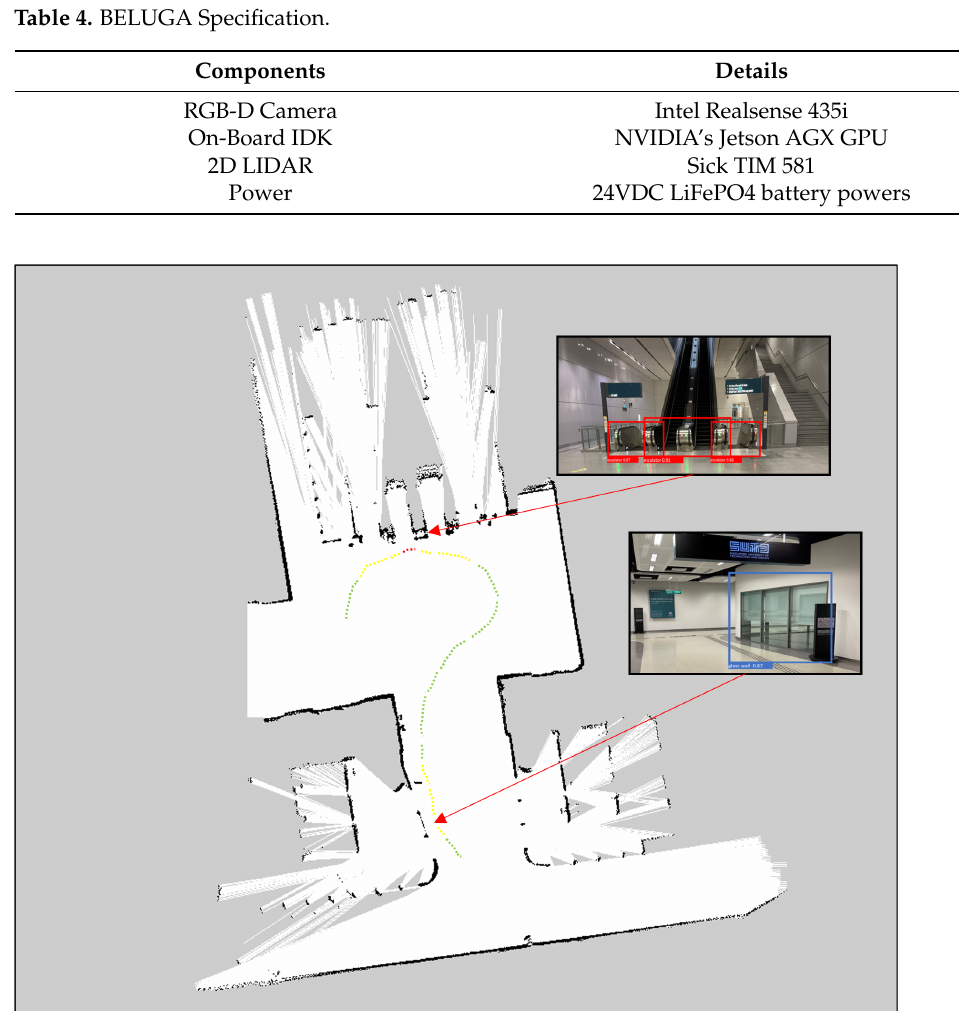
Figure 6. Environment: SUTD Mass Rapid Transition (MRT)